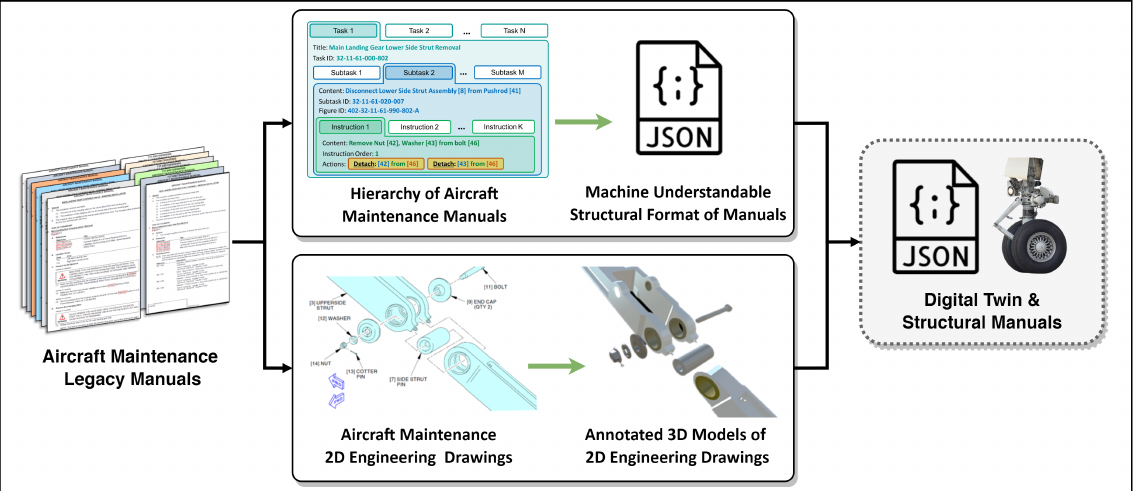
Figure 2. Digital twin content